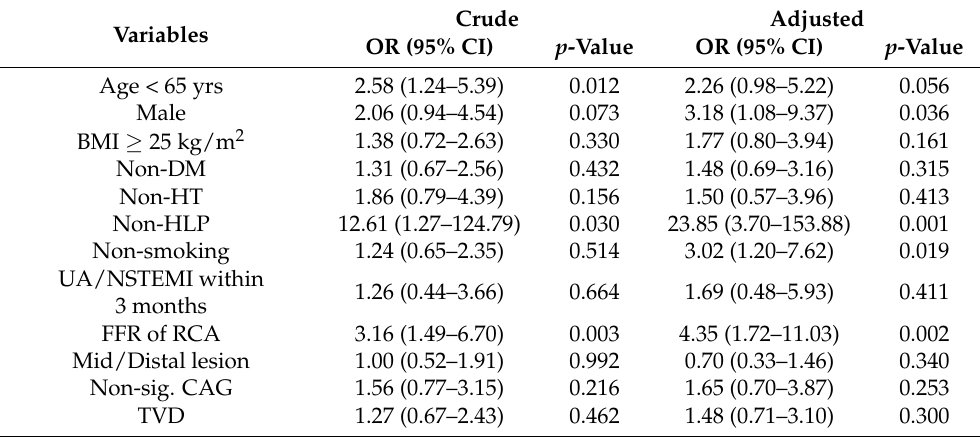
Table 4. Crude and adjusted odds ratio of predictors in which the FFR ≤ 0.8 occurred at adenosine 150, 200 mcg.